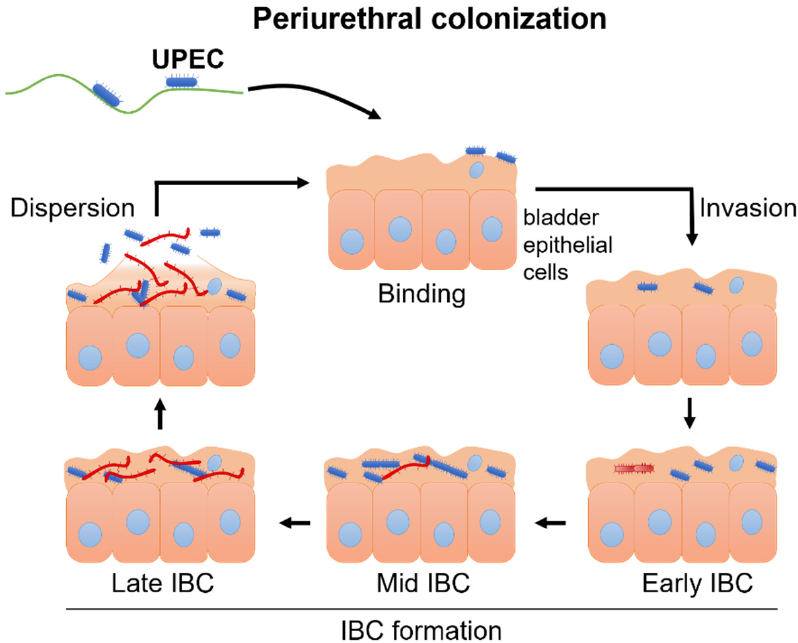
Figure 2. Model of the urinary tract infection cascade. UPEC—uropathogenic E. coli ; IBC—intracellular bacterial communities.